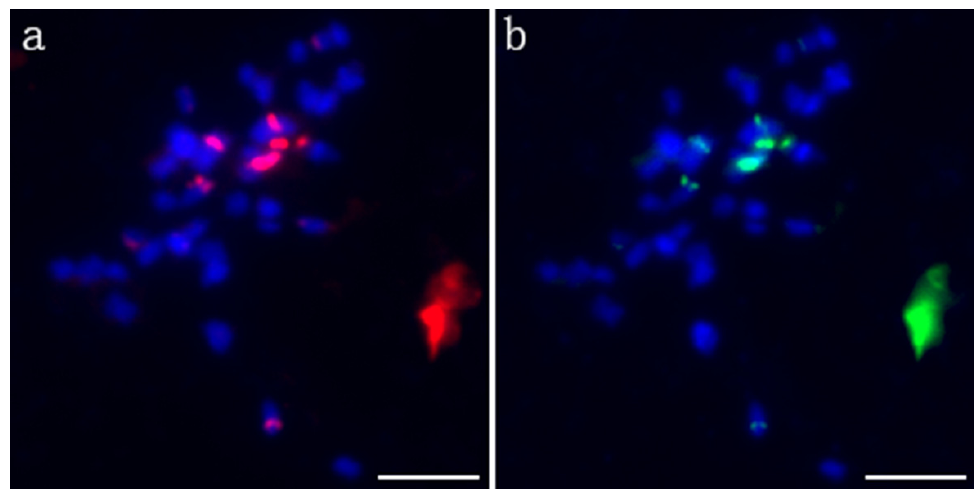
Figure 2. FISH patterns of pPD284_XHY and pPC349_XHY of P. xiaohei . ( a ) pPD284_XHY (red); ( b ) pPC349_XHY (green). Bars = 5 μ m.